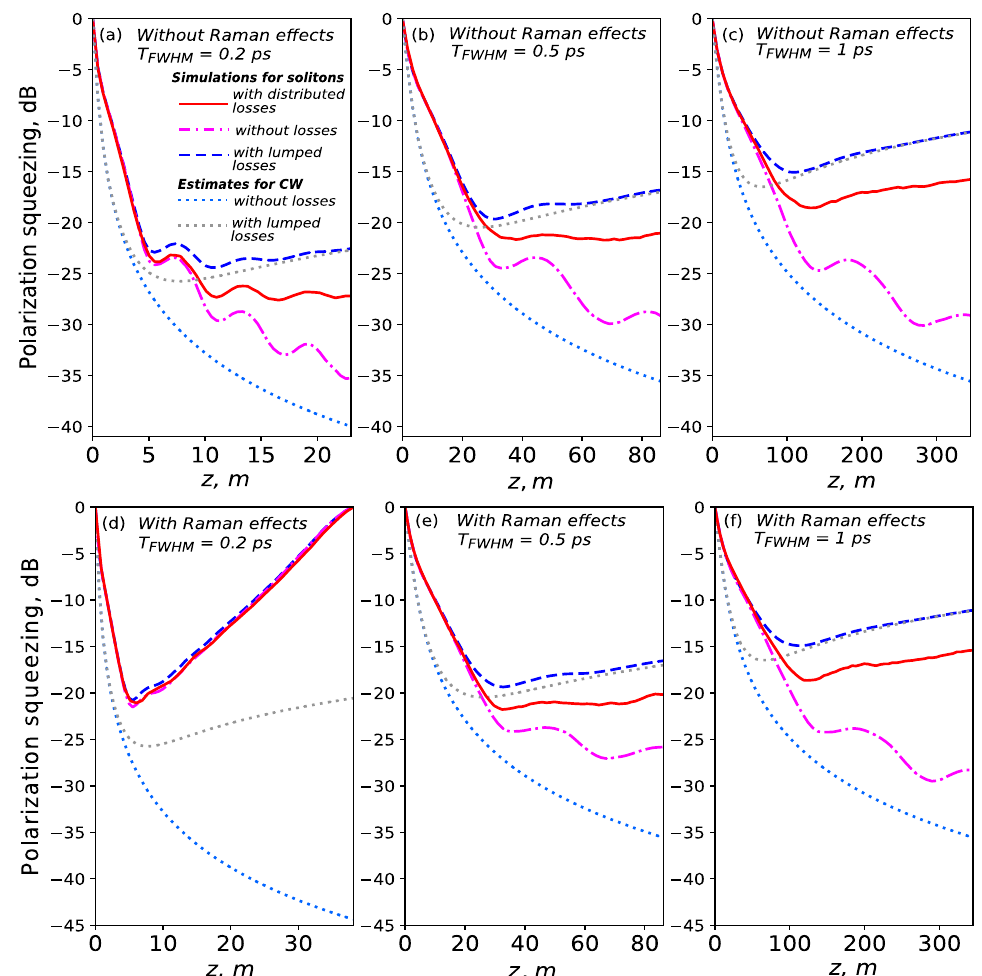
Figure 3. Polarization squeezing simulated without Raman effects for pulse durations of 0.2 ps ( a ), 0.5 ps ( b ), and for 1 ps ( c ) and with full Raman contribution for pulse durations of 0.2 ps ( d ), 0.5 ps ( e ), and for 1 ps ( f ) compared to analytical estimates for squeezing of CW light using Formulas (18) and (19). The legend given in subplot ( a ) is the same for all subplots. Solid red lines correspond to simulations of Equation (3) with distributed losses; dashed-doted magenta lines correspond to simulations of Equation (3) without any losses; dashed blue lines correspond to simulations of Equation (3) without distributed losses but with lumped losses; dotted light-blue and gray lines correspond to analytical estimates of squeezing of CW light without losses and with lumped losses, respectively.